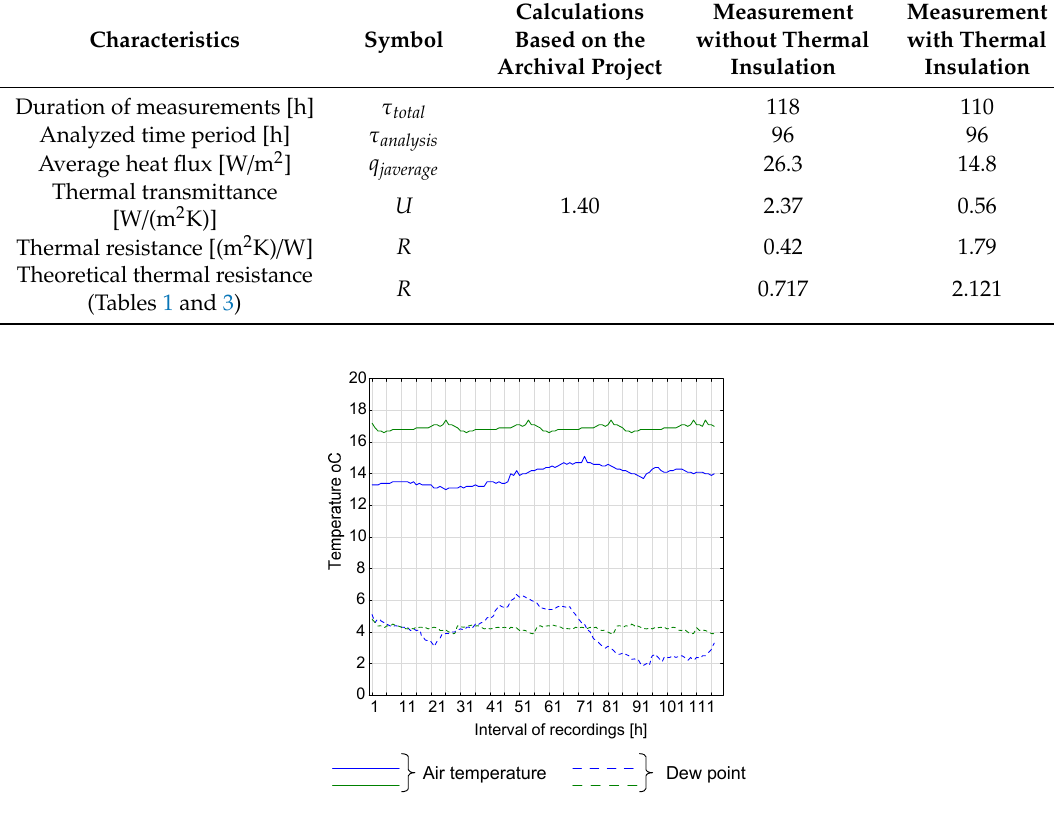
Figure 8. Measurement of indoor microclimate. Blue color—the measurement without thermal insulation taken on 27 January 2018–01 February 2018 Green color—the measurement with thermal insulation taken on 17 February 2018–18 February 2018.